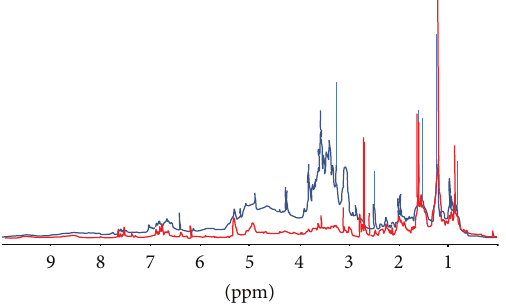
Figure 1: Comparative 1 H-NMR of two Hypericum perforatum . Extracts; the 2 extracts have been manufactured starting from the same aerial parts, by the same solvents and have the same chemical titre (0.3%